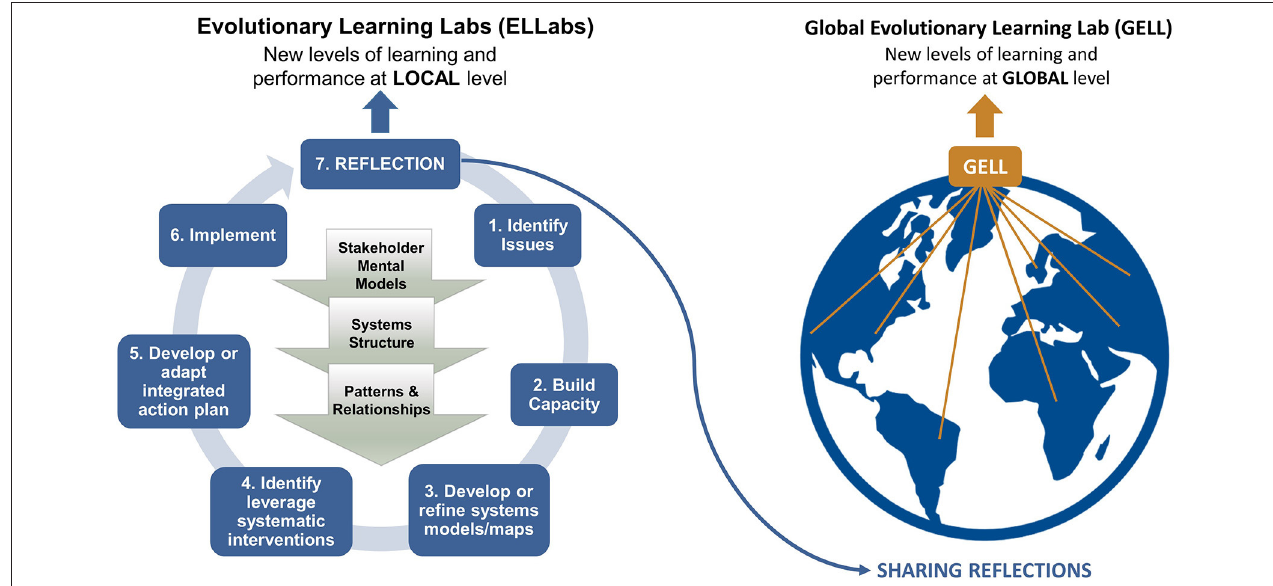
FIGURE 1 | The local Evolutionary Learning Laboratory (ELLabs) and the Global Evolutionary Learning Laboratory (GELL) (adapted from Bosch et al.,